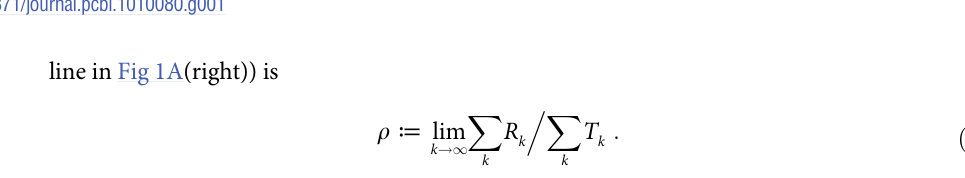
Fig 1. AR-RL and performance-gated deliberation. (A) Task setting. Left: Within trial state, S indexed by k . The decision ‘A’ is reported at the decision time t dec of cumulative reward versus cumulative duration. Context-conditioned reward rate (slope of red line), varies with alternating context (labelled 1 and 2) around average reward, ρ (dashed line). (B) Decision rules based on opportunity costs of commitment, C com AR-RL rule (black ‘x’) finds t that minimizes C del diagram of each algorithm’s dependency. PGD computes a decision time directly from the two opportunity costs, while AR-RL uses both to first estimate a value function, whose maximum specifies the decision time. (D) Loss (error in performance with respect to the optimal policy, ( ρ � − ρ )/ ρ � ) over learning time in a patch-leaving task (AR-RL: brown, PGD: black). The arrow indicates when the state labels were randomly